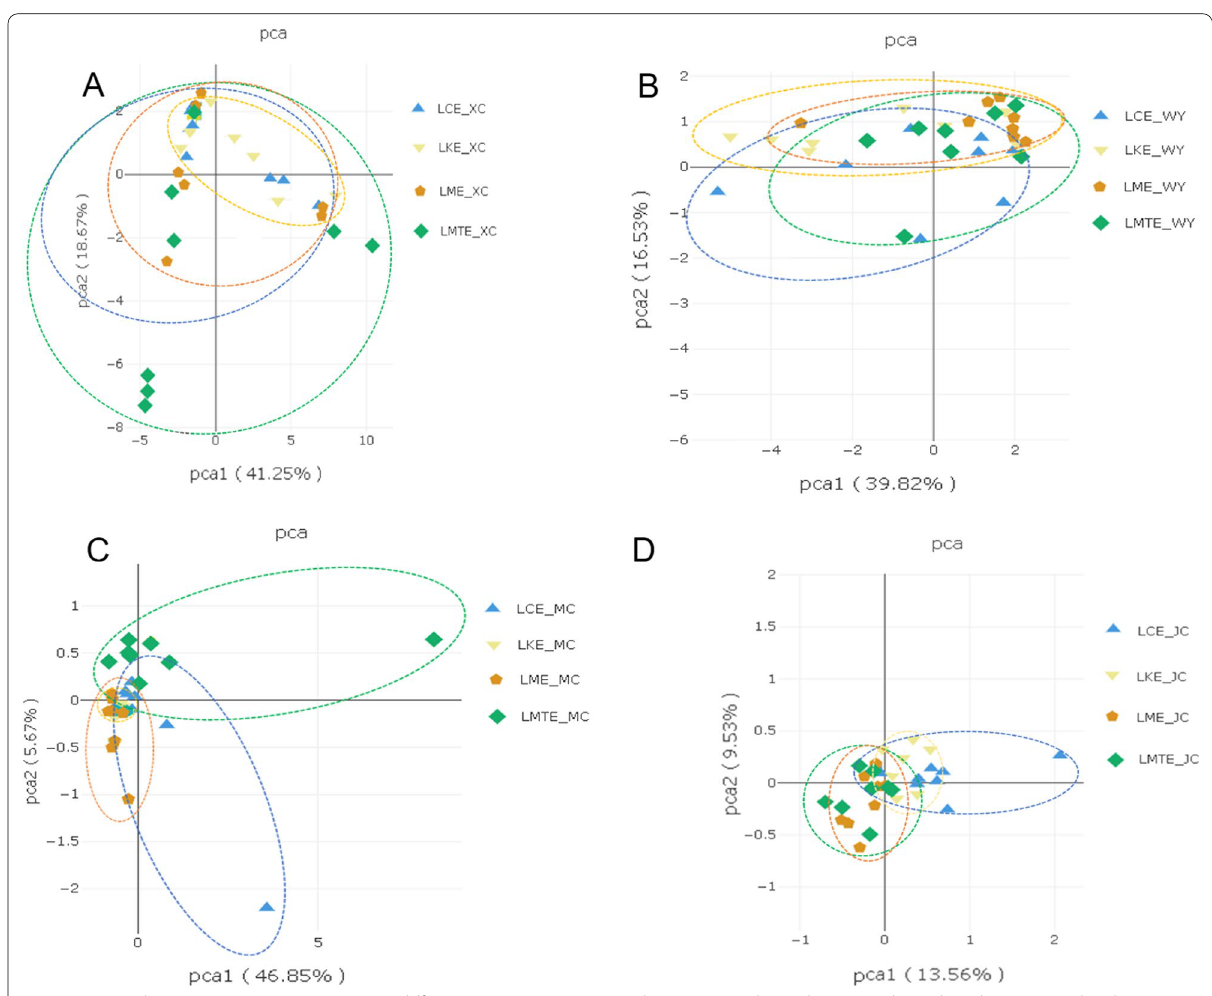
Fig. 5 Bacterial community composition were different among LC, LK, LM and LMT. Principal coordinates analysis plots show unweighted UniFrac distances in four group piglets (PERMANOVA: unweighted R2 represent the gut bacterial communities of LC (blue), LM (yellow), LK (brown) and LMT (green) piglets. A jejunum. B succus gastricus. C cecum. D